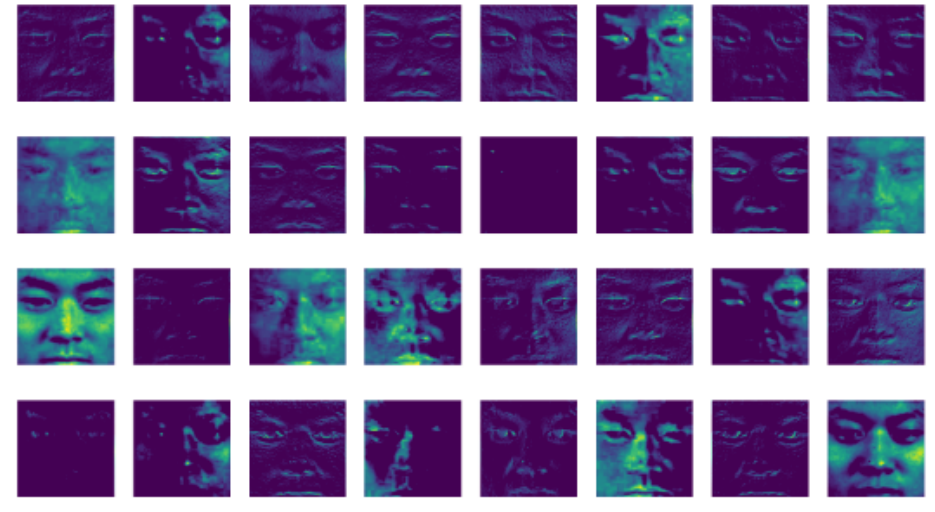
Figure 4. Attention ResNet-92 (Stage-1) hidden layer visualization of residual learning.